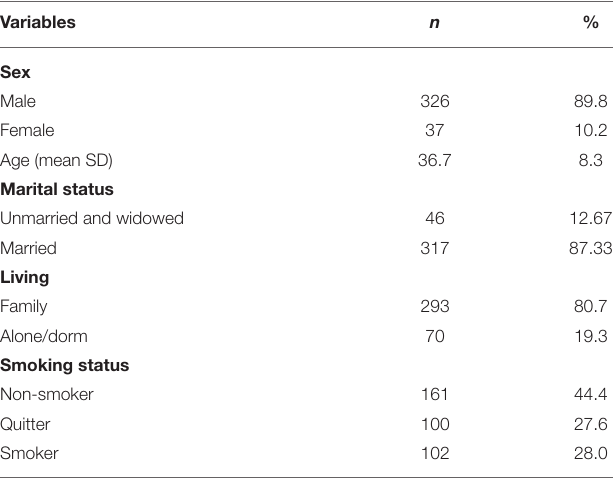
TABLE 1 | Respondents’ characteristics ( n = 363).